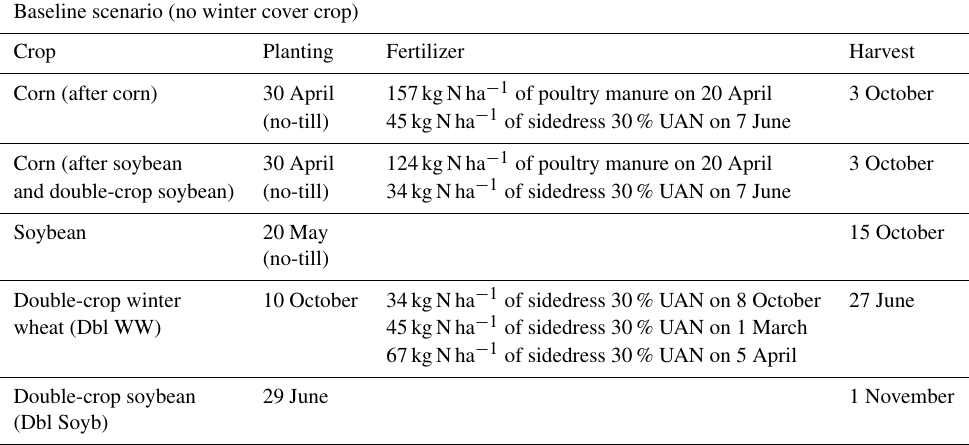
Table A1. Management schedules for the baseline scenario (adapted from Lee et al., 2016a).